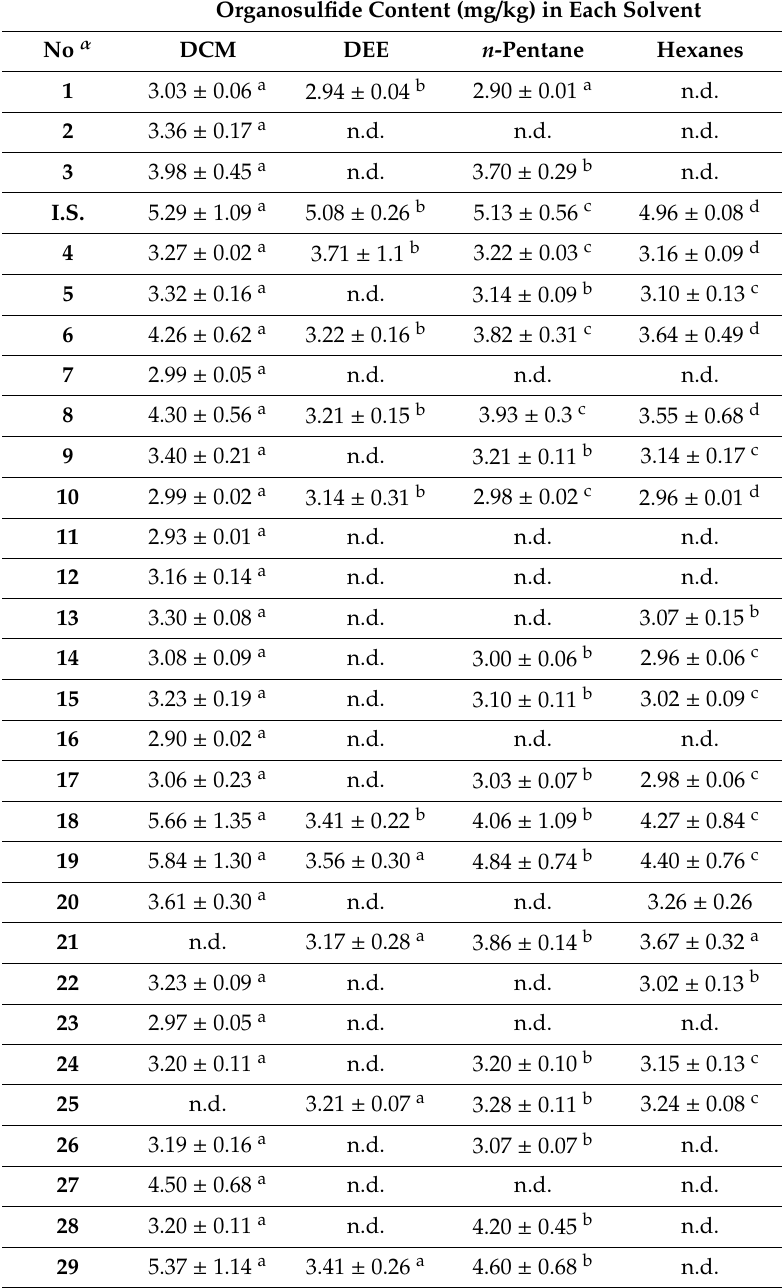
Table 2. Semi-quantitative organosulfide content from each extraction